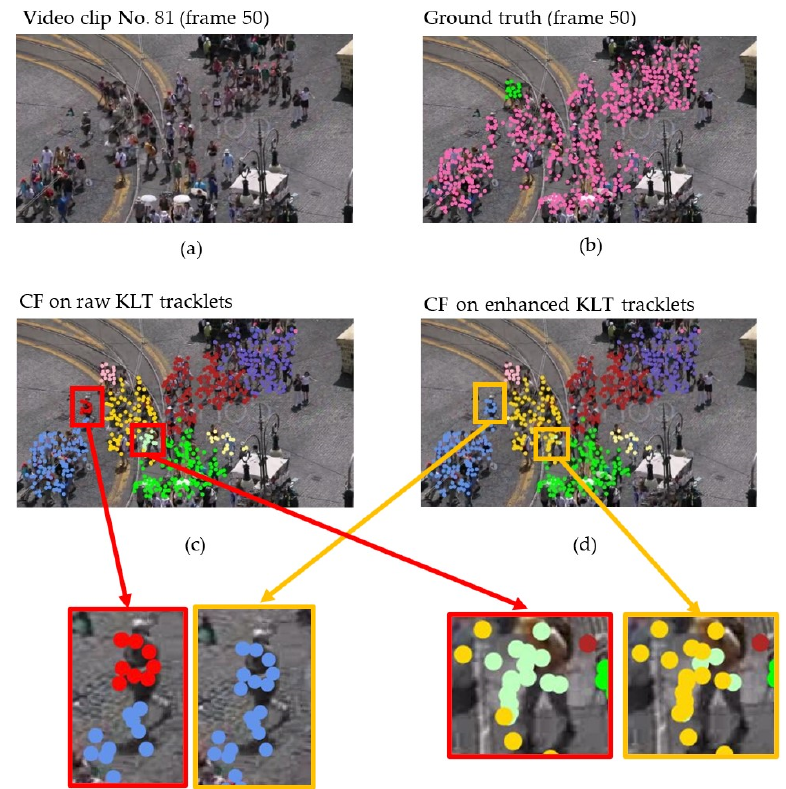
Figure 9. An example of the effect of applying HTA algorithm on KLT tracklets of video clip No. 81. Colored KLT points represent coherent moving clusters. ( a ) Scene of video clip No. 81—frame 50. ( b ) Ground truth—frame 50. ( c ) The visual results of CF crowd motion clustering using the raw KLT tracklet features. ( d ) The visual results of CF crowd motion clustering using the enhanced KLT tracklet features by HTA algorithm.